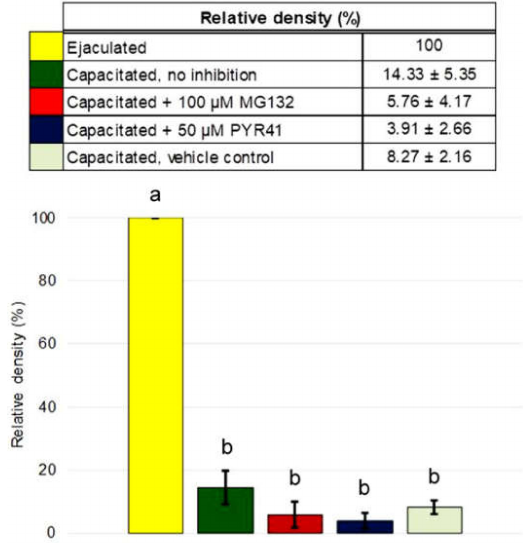
Figure 5. Densitometric quantification of 12 kDa immunoreactive MSMB bands from Figure 4 in protein extracts of ejaculated spermatozoa and all capacitated sperm treatment groups. The relative density of MSMB in the blot was calculated as the ratio of the optical density of anti- MSMB and anti- α -tubulin antibodies; the MSMB amount in the ejaculated sperm sample was defined as 100%, and all IVC sperm treatment groups were compared to ejaculated spermatozoa. Results are presented as the mean ± SD of four independent biological replicates. Statistical significance ( p < 0.05) is indicated by